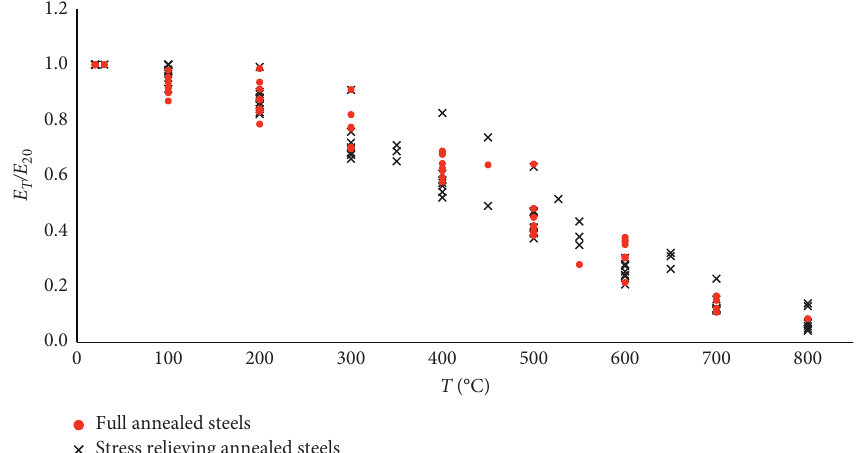
Figure 18: Comparison of the retention factors of elastic modulus for cold-rolled thin-walled steels according to test results with available research